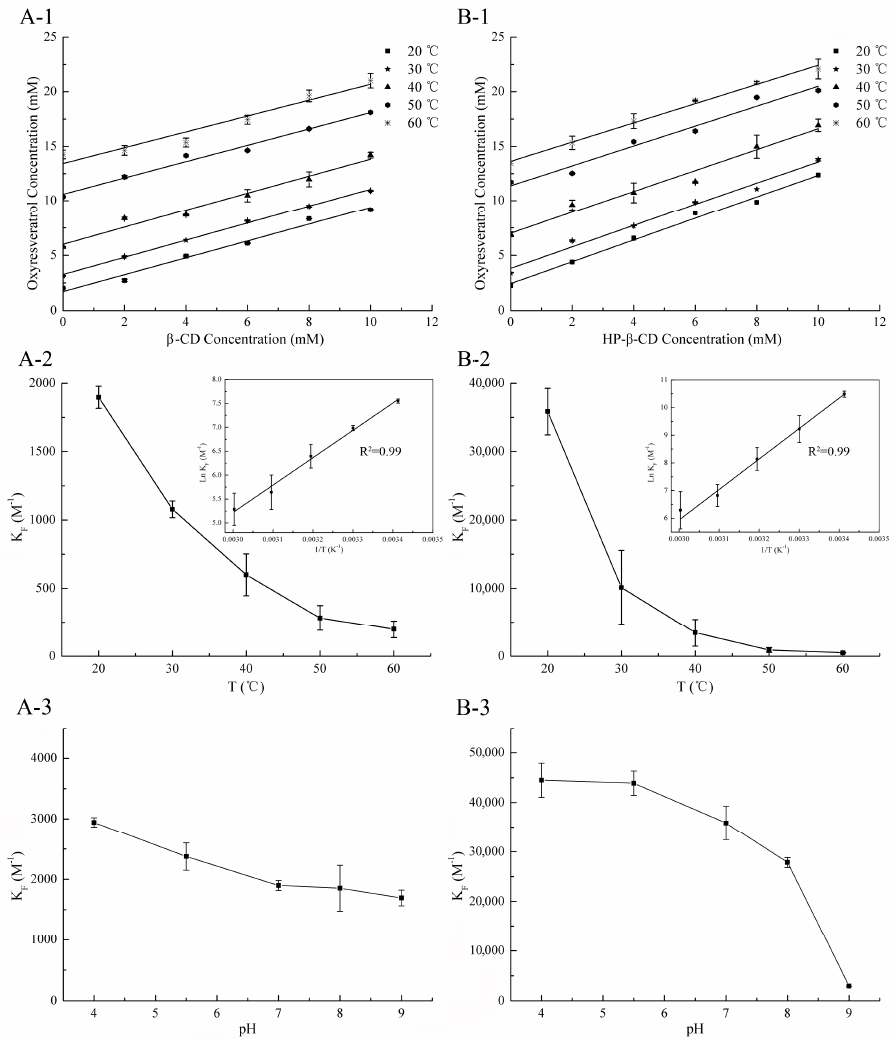
Figure 3. Oxyresveratrol/ β -CD ( A-1 ) and oxyresveratrol/HP- β -CD ( B-1 ) phase solubility diagrams at different temperatures. Effect of temperatures on the complexation constant ( K F ) of oxyresveratrol- β - CD inclusion complex ( A-2 ) and oxyresveratrol-HP- β -CD inclusion complex in H 2 O ( B-2 ). Inset: the in H 2 O ( B-2 ). Inset: the Van’t Hoff plot (ln K F versus 1/T) for oxyresveratrol- β -CD ( A-2 ) and Van’t Hoff plot (ln K F versus 1/T) for oxyresveratrol- β -CD ( A-2 ) and oxyresveratrol-HP- β -CD ( B-2 ) oxyresveratrol-HP- β -CD ( B-2 ) inclusion complexes. Effect of pH on the K F of oxyresveratrol- β -CD inclusion complexes. Effect of pH on the K F of oxyresveratrol- β -CD inclusion complex ( A-3 ) and inclusion complex ( A-3 ) and oxyresveratrol-HP- β -CD inclusion complex ( B-3 ). ( n = 3, if no error bars oxyresveratrol-HP- β -CD inclusion complex ( B-3 ). ( n = 3, if no error bars are displayed, errors were are displayed, errors were smaller than smaller than symbols).